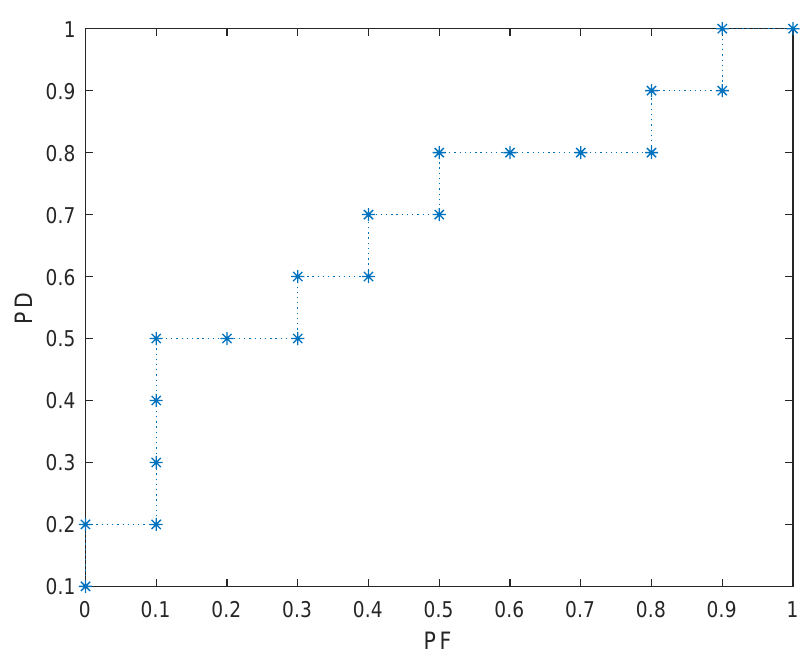
Figure 1. An example of ROC